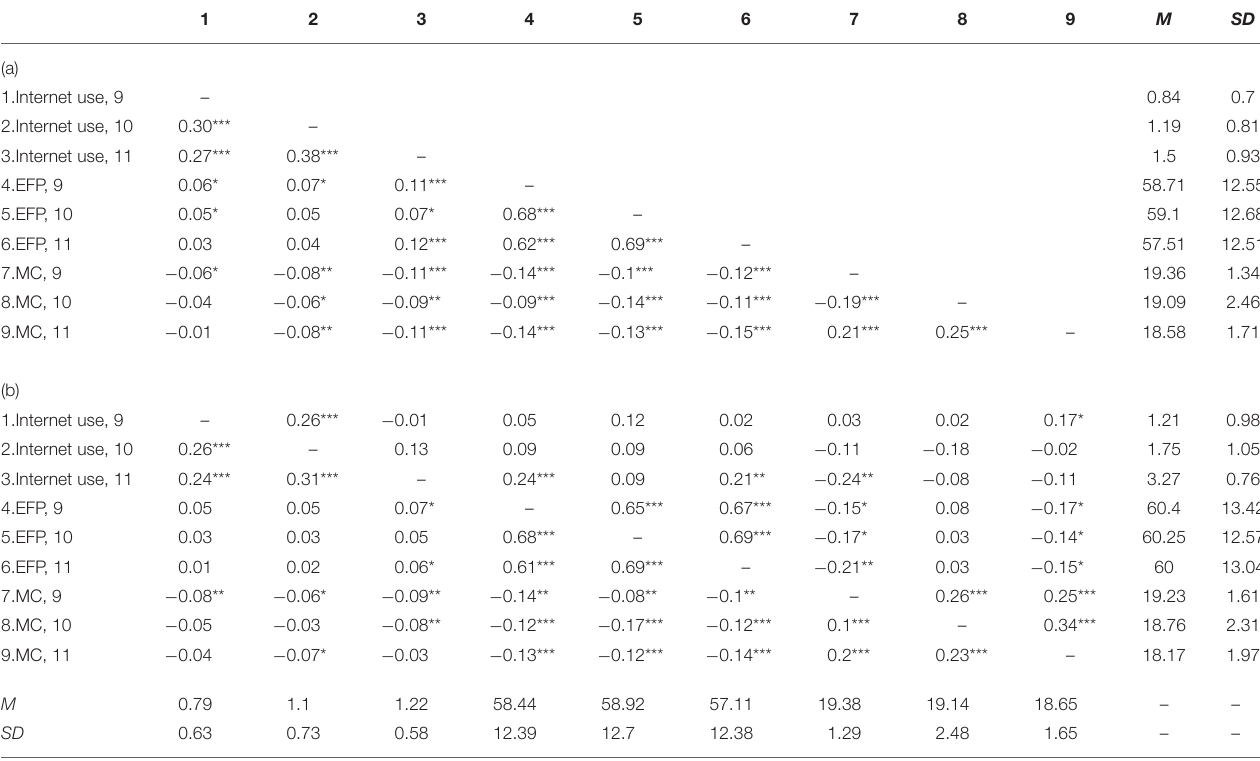
TABLE 1 | Descriptive statistics and bivariate correlations comparing high-risk and low-risk